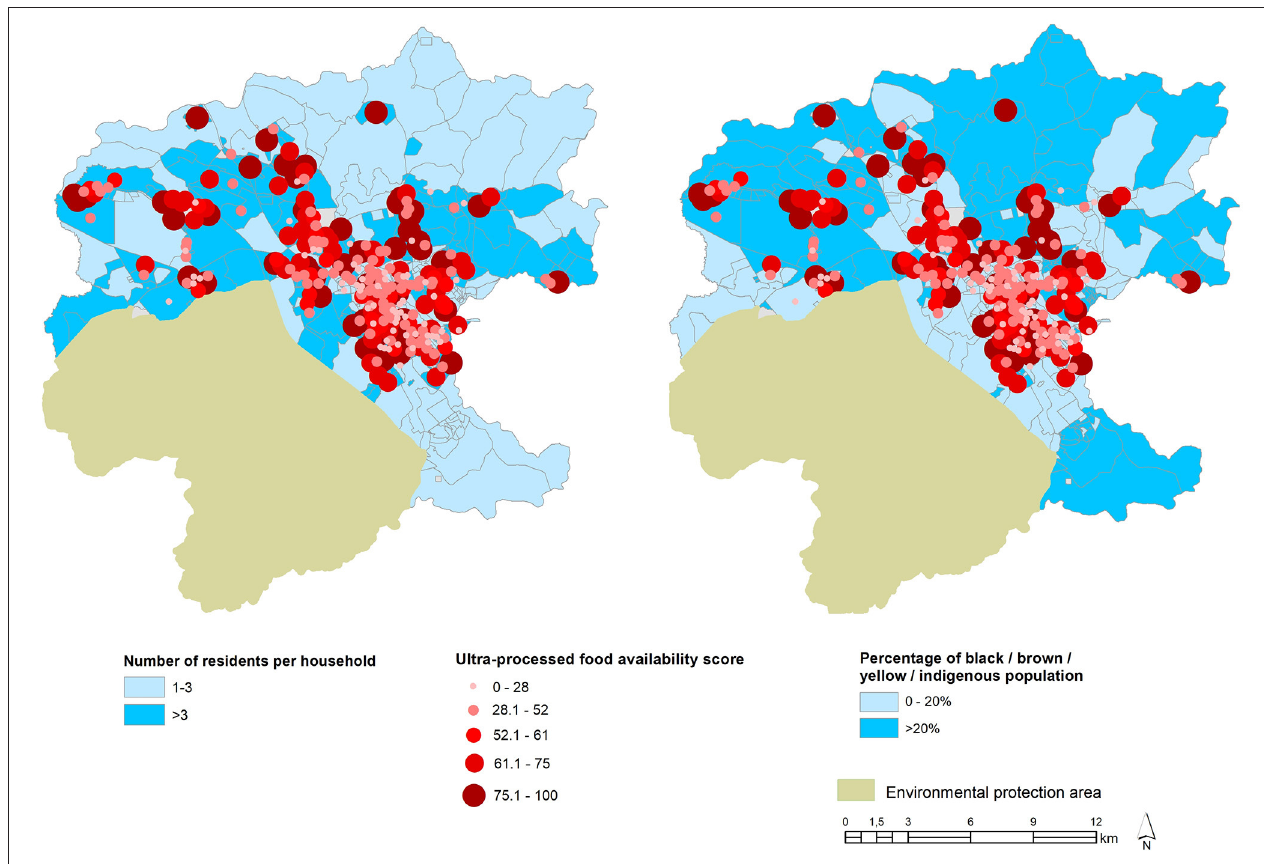
FIGURE 3 | Ultra-processed food availability score and sociodemographic variables in the municipality of Jundiaí, SP, Brazil, 2017–2018.